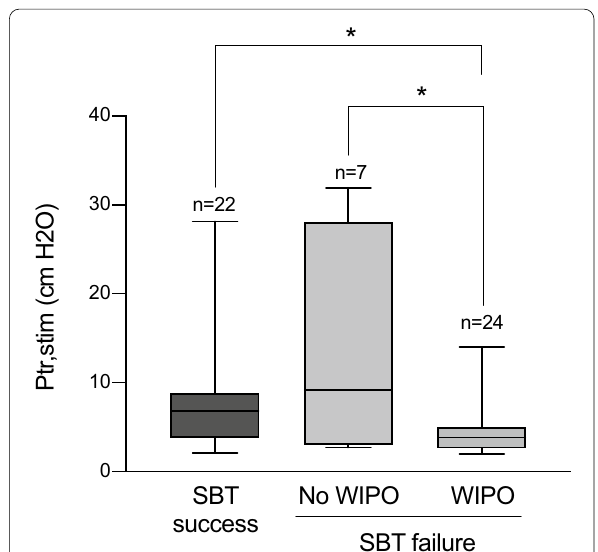
Fig. 3 Diaphragm function as evaluated by measuring the change in tracheal pressure in response to bilateral phrenic nerve stimulation (Ptr,stim) in patients with a successful spontaneous breathing trial (SBT) and those with SBT failure with and without weaning-induced pulmonary oedema (WIPO). Box plots show the median